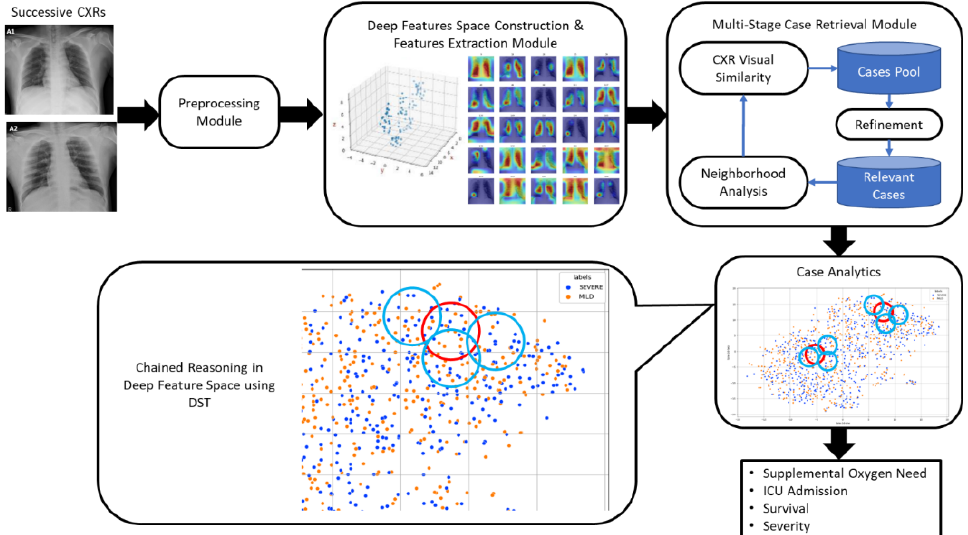
Figure 1. Proposed Framework.